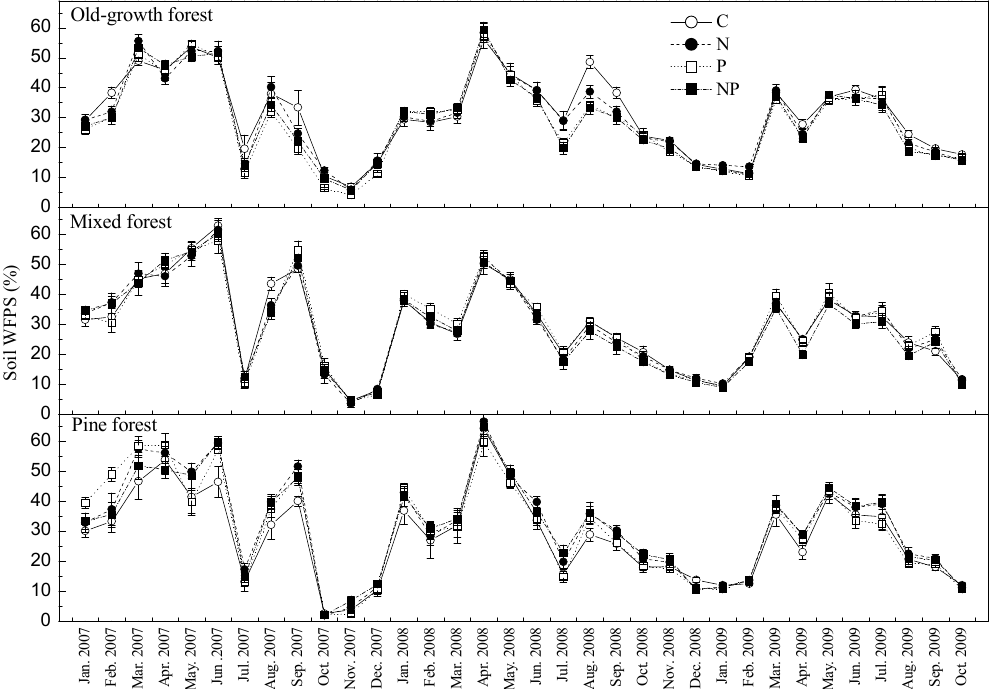
Figure 2. Monthly soil WFPS in the three study forests of Dinghushan Biosphere Reserve (DHSBR) from January 2007 to October 2009.